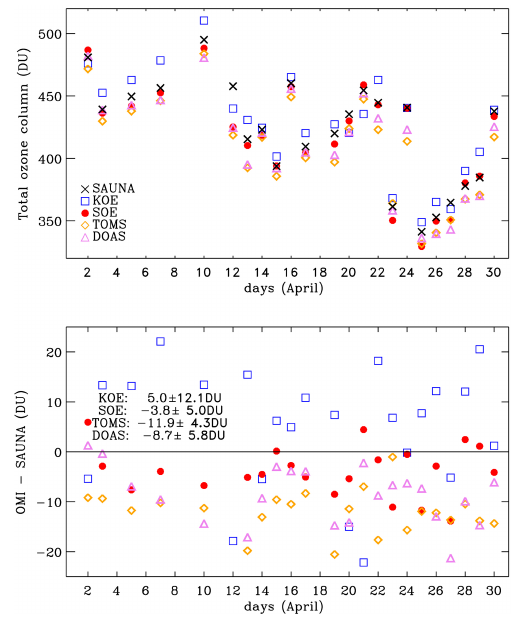
Figure 4. Time series of SAUNA data (Brewer reference) and OMI total column ozone for April 2006 (upper panel). Time series of the relative differences between OMI and SAUNA total ozone (lower